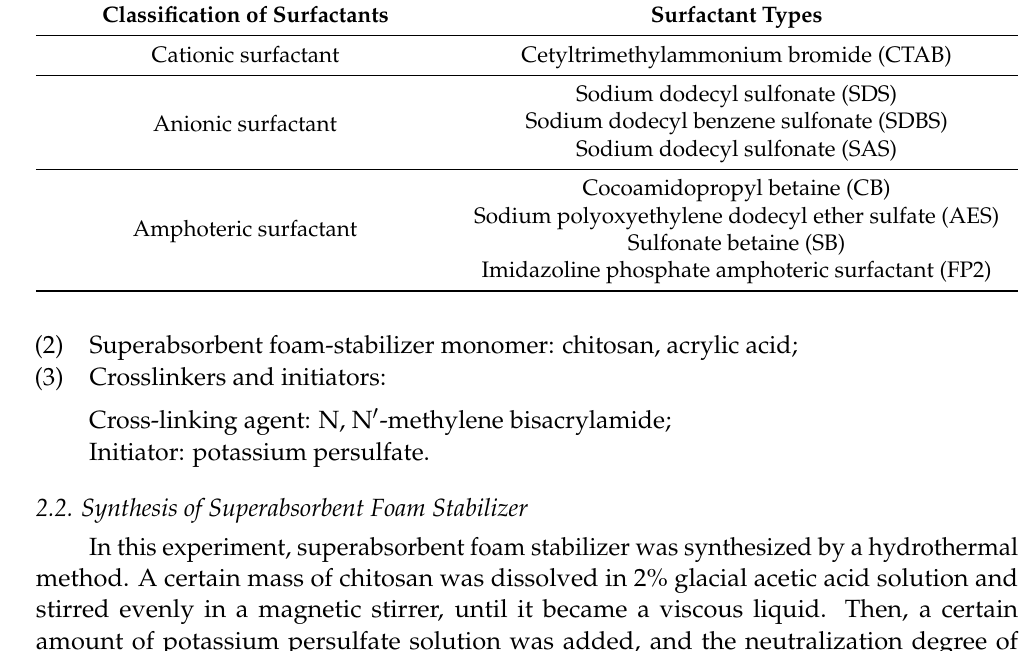
Table 1. Types of surfactants. Classification of